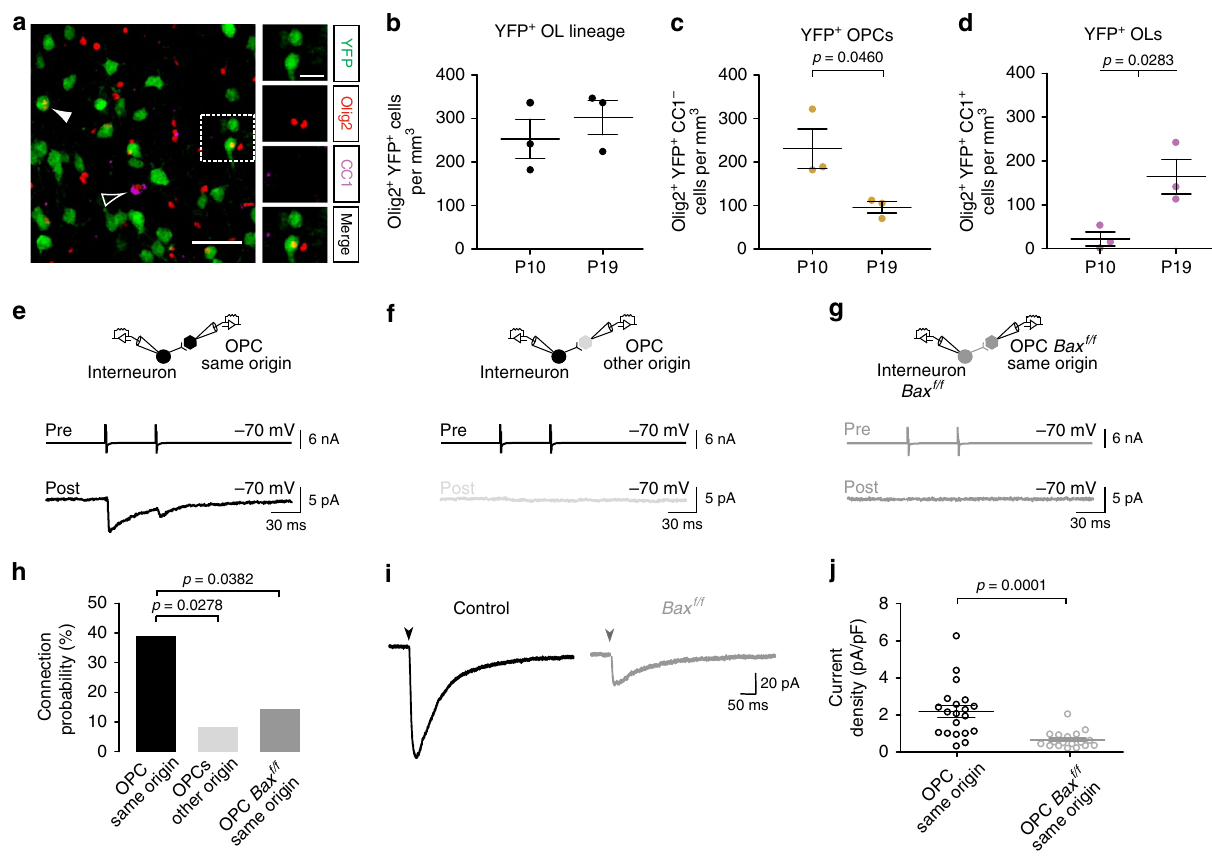
Fig. 5 The preferential interneuron- fi rstOPC connectivity is reduced in Bax f/f mice. a Confocal images of YFP + (green), Olig2 + (red) and CC1 + cells in layer V of the somatosensory cortex in a Nkx2.1 CRE ;Rosa26 YFP mouse at PN10. The white dotted square surrounds a YFP + interneuron and a YFP + /Olig2 + /CC1 − OPC shown in insets. Another YFP + /Olig2 + /CC1 − OPC (solid arrowhead) and a YFP − /Olig2 + /CC1 + OL (open arrowhead) are indicated. Scale bars: 100 and 20 µ m. b – d Layer V and VI densities of YFP + /Olig2 + cells ( b ), YFP + /Olig2 + /CC1 − OPCs ( c ) and YFP + /Olig2 + /CC1 + OLs ( d ) at PN10 and PN19 in the somatosensory cortex of Nkx2.1 CRE ;Rosa26 YFP mice (dots represent n = 3 mice per age). e – g Paired recordings between a presynaptic fl uorescent interneuron and an OPC of the same origin ( e ) or a different origin ( f ) in control mice, or between a presynaptic tdTomato + interneuron and a tdTomato + OPC of the same origin in Bax f/f mice ( g ). h Connection probabilities for OPCs of the same origin in control (black, n = 36), OPCs of different origin in control (light gray, n = 24) and OPCs of the same origin in Bax f/f mice (dark gray, n = 35). Note that presynaptic interneurons target preferentially OPCs of the same origin in control (black) compared to OPCs of different origin (light gray) or OPCs of same origin but after Bax inactivation (dark gray; Chi- squared test; signi fi cant p -values are indicated). i GABAergic PSCs evoked by stimulation of neuronal fi bers (100 µ s; 20 V) in fi rstOPCs of control (black) and Bax f/f mice (dark gray) recorded at − 70 mV in the presence of 10 µ M 2,3-dioxo-6-nitro-1,2,3,4-tetrahydrobenzoquinoxaline-7-sulfonamide (NBQX) and 50 µ M D-( − )-2-amino-5-phosphonopentanoic acid (D-AP5), showing a reduced mean GABAergic PSC in the Bax f/f mouse. Stimulation artefacts were blanked for visibility. The stimulation time is indicated (arrowheads). j Dot plots of current densities for fi rstOPCs in control (black; n = 20) and Bax f/f (dark gray; n = 18) mice calculated by dividing the mean amplitude of evoked PSCs by the cell capacitance. Note the decreased PSC densities in knockout mice (Mann – Whitney U test; signi fi cant p -value is indicated). Data in b – d and j are presented as mean ±